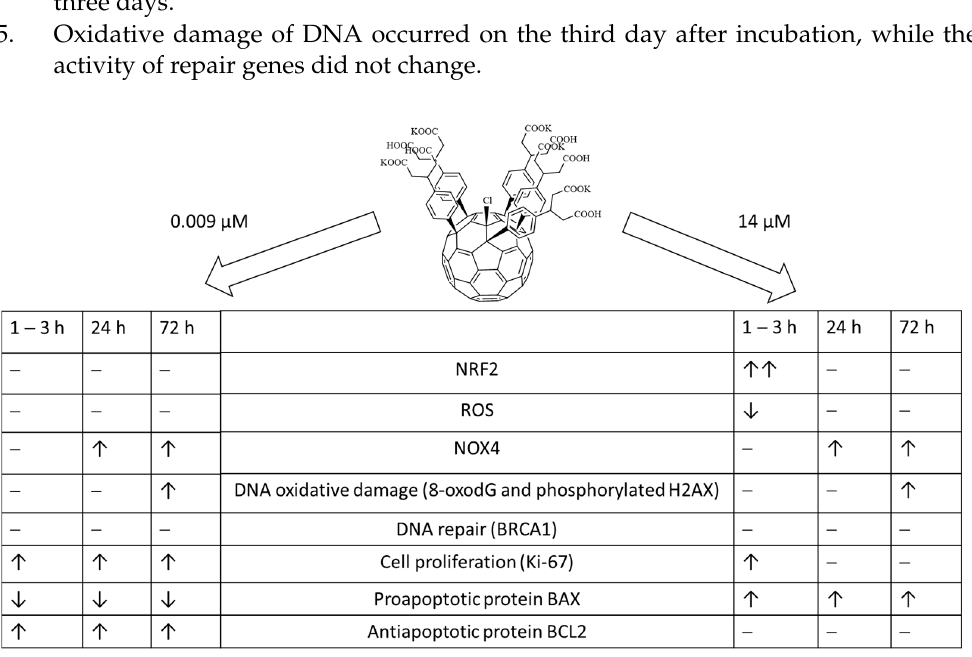
human embryonic lung